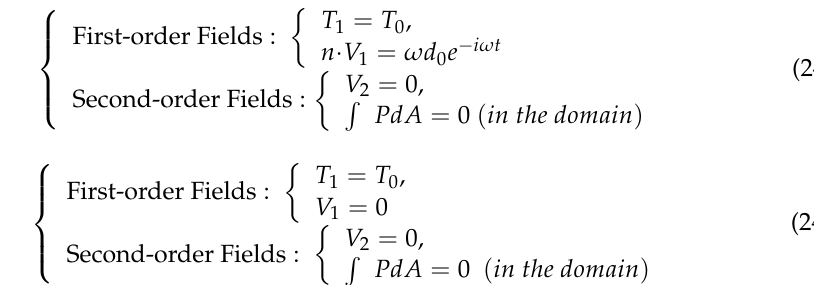
Table 3. Parameters of the model used in Ref. [43], which have been re-simulated here.